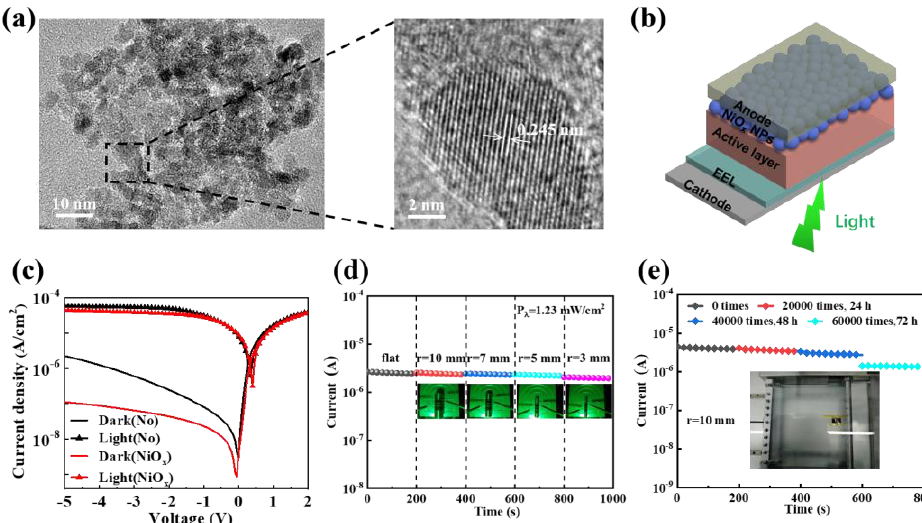
Figure 17. ( a ) TEM image and HRTEM image of NiO x particles; ( b ) Device architecture of inverted OPDs with NiO x as EBL; ( c ) J-V curves of OPD with or without NiO x -EBL carried out with 339 µW cm −2 green LED light. (Reproduced with permission from [141]. IOPscience Publishing, 2020). Device performance in the photocurrent measured after ( d ) bending at different radii and ( e ) different times of continuous bending. (Reproduced with permission from [142]. IEEE Xplore Publishing, 2020).